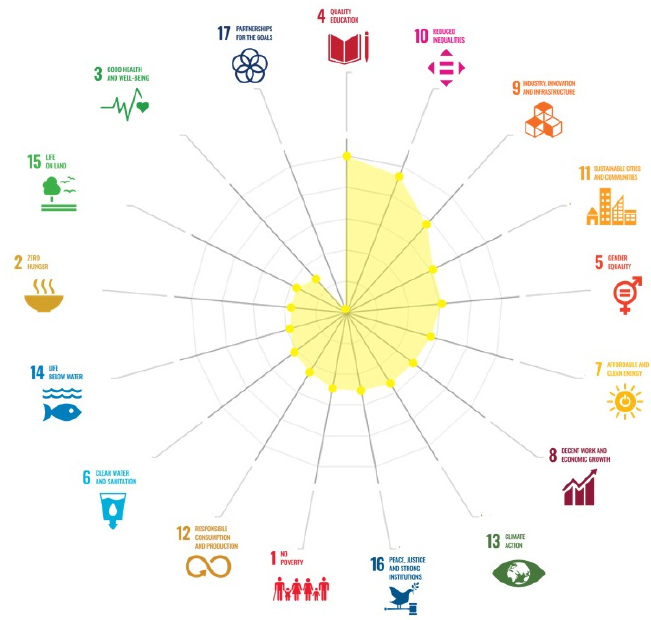
Figure 2. Radar graph of disclosed SDGs.